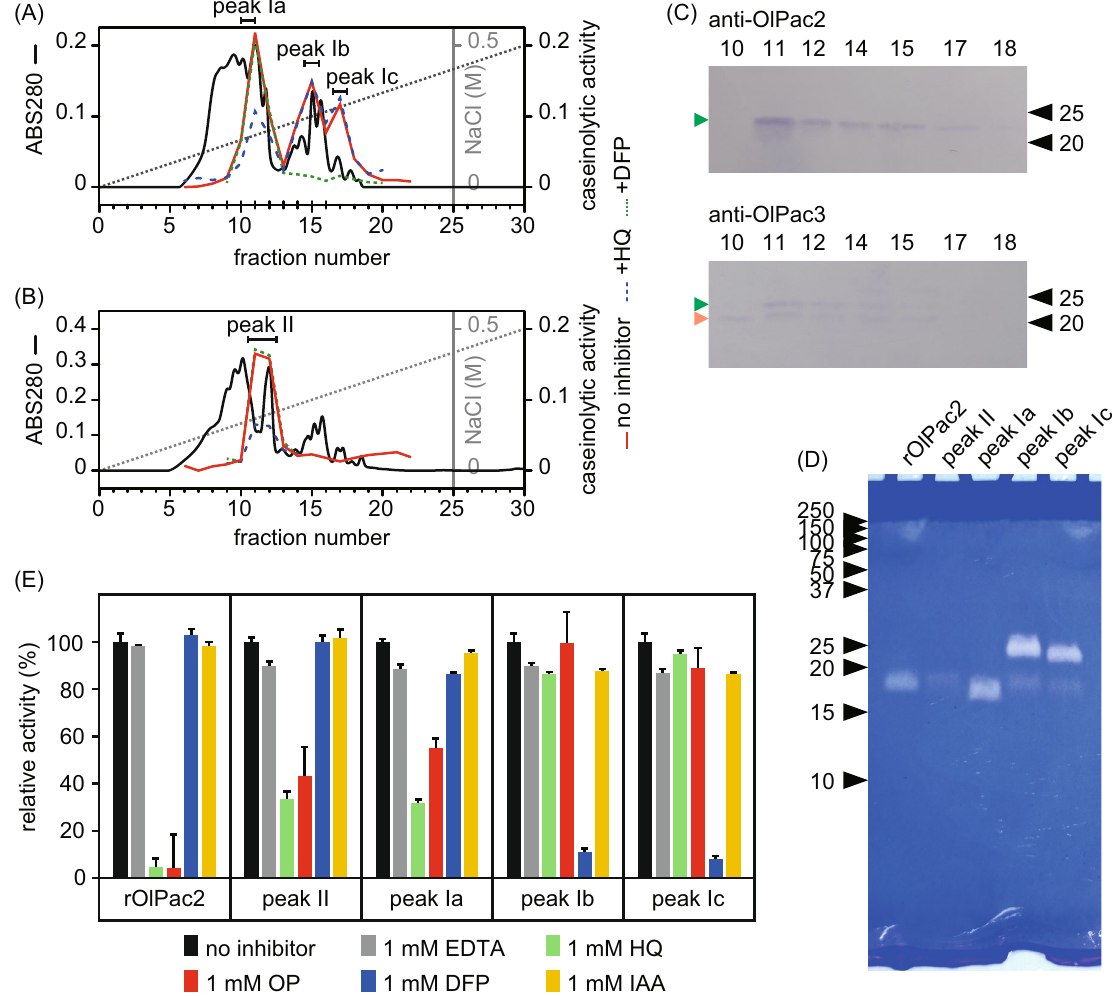
Figure 8. Pactacin activity in the digestive fluid of medaka. Source 15Q chromatogram of untreated ( A ) and DFP-treated digestive fluid ( B ). Black line, protein amount; red line, caseinolytic activity; blue broken line, caseinolytic activity following 1 mM HQ treatment; green dotted line, caseinolytic activity following 1 mM DFP treatment; gray dotted line, NaCl concentration. ( C ) Western blot of (untreated) fractions 10, 11, 12, 14, 15, 17, and 18. Anti-OlPac2 or anti-OlPac3 antibodies were used. Black triangles indicate molecular marker positions (values are indicated in kDa). Green triangles indicate the positive signal from the anti-OlPac2 antibody (upper panel) or the cross reaction of the anti-OlPac3 antibody with OlPac2 (lower panel). The orange triangle indicates the signal from the anti-OlPac3 antibody. Band regions are cropped, and full-length photos are included in a Supplementary Information. ( D ) Casein acrylamide gel zymography of rOlPac2 and peaks Ia, Ib, Ic, and II. Numbers indicate the molecular mass (kDa) of molecular markers. ( E ) Inhibition of caseinolytic activity of rOlPac2 and peaks Ia, Ib, Ic and II. Values (%) indicate activity following treatment with 1 mM EDTA (gray), HQ (green), OP (red), DFP (blue) or IAA (yellow) relative to that of untreated